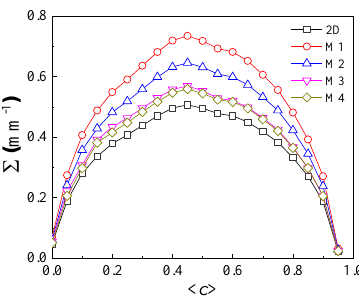
Figure 7. The variation in two–dimensional flame surface density and the evaluation with the mean progress variable, at 0.5 MPa. Only this case is shown here due to brevity, since the behaviors observed under three pressures are the